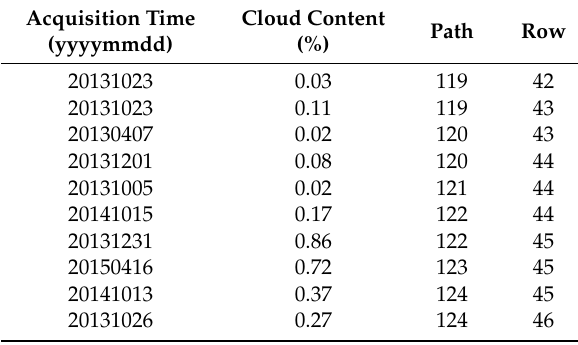
Table 2. Landsat 8 data and their